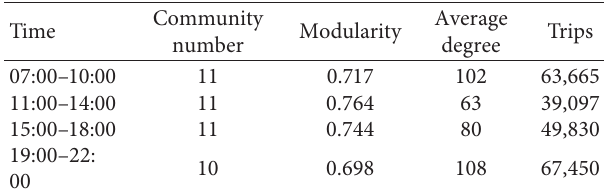
Table 2: The number of communities for each period in the center Shenzhen bike